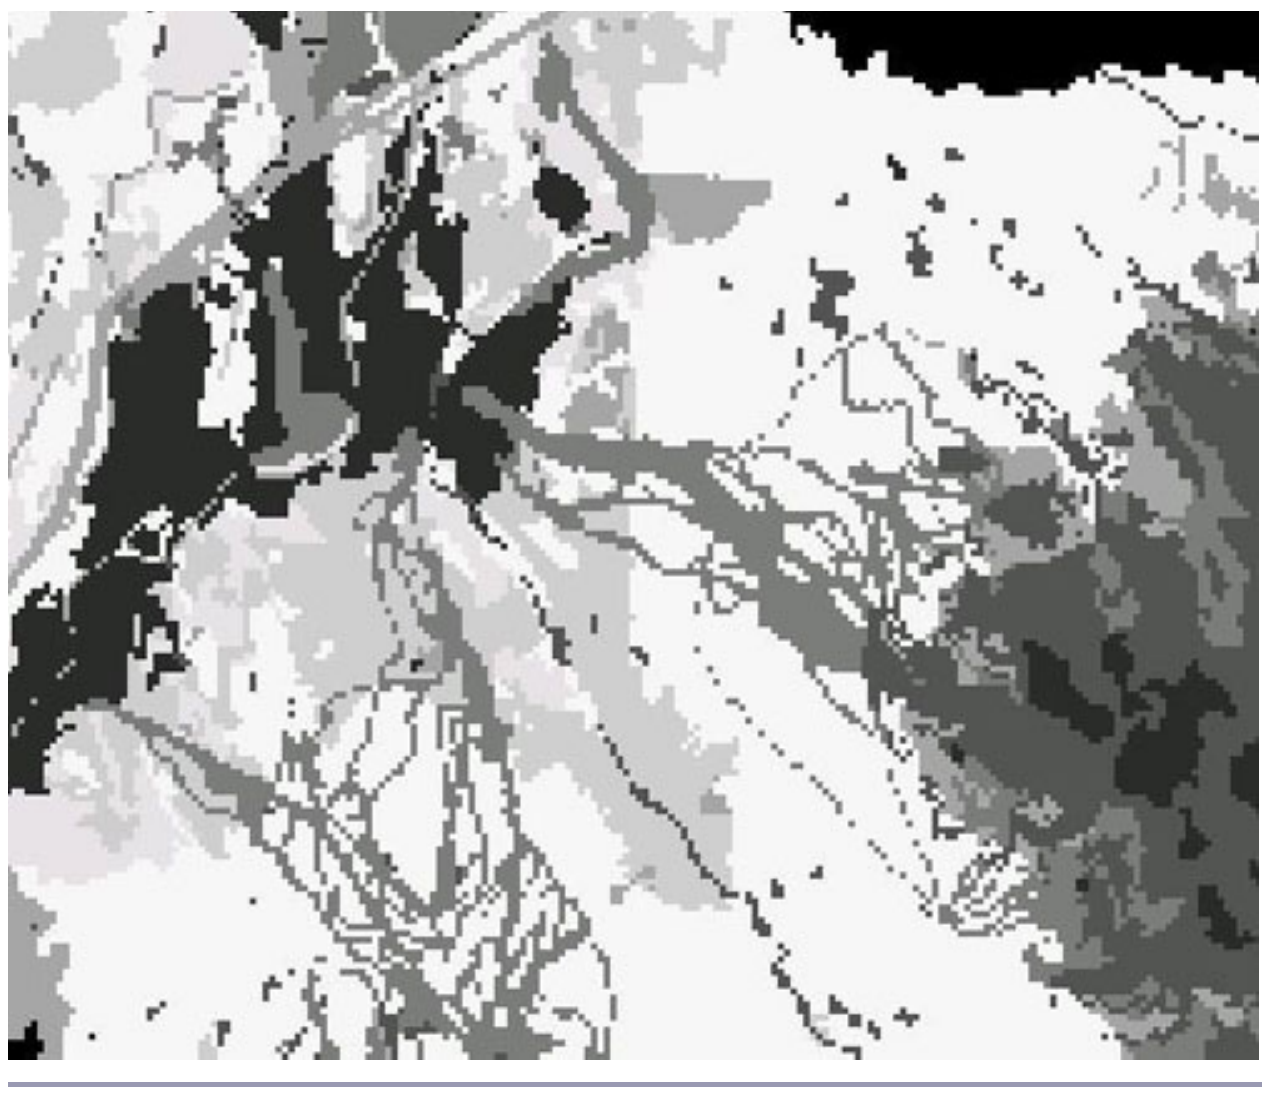
Fig. 6 . A resistance layer representation of an 8000 ha area in the Resort Municipality of Whistler, British Columbia, Canada. Darker colors indicate higher resistance